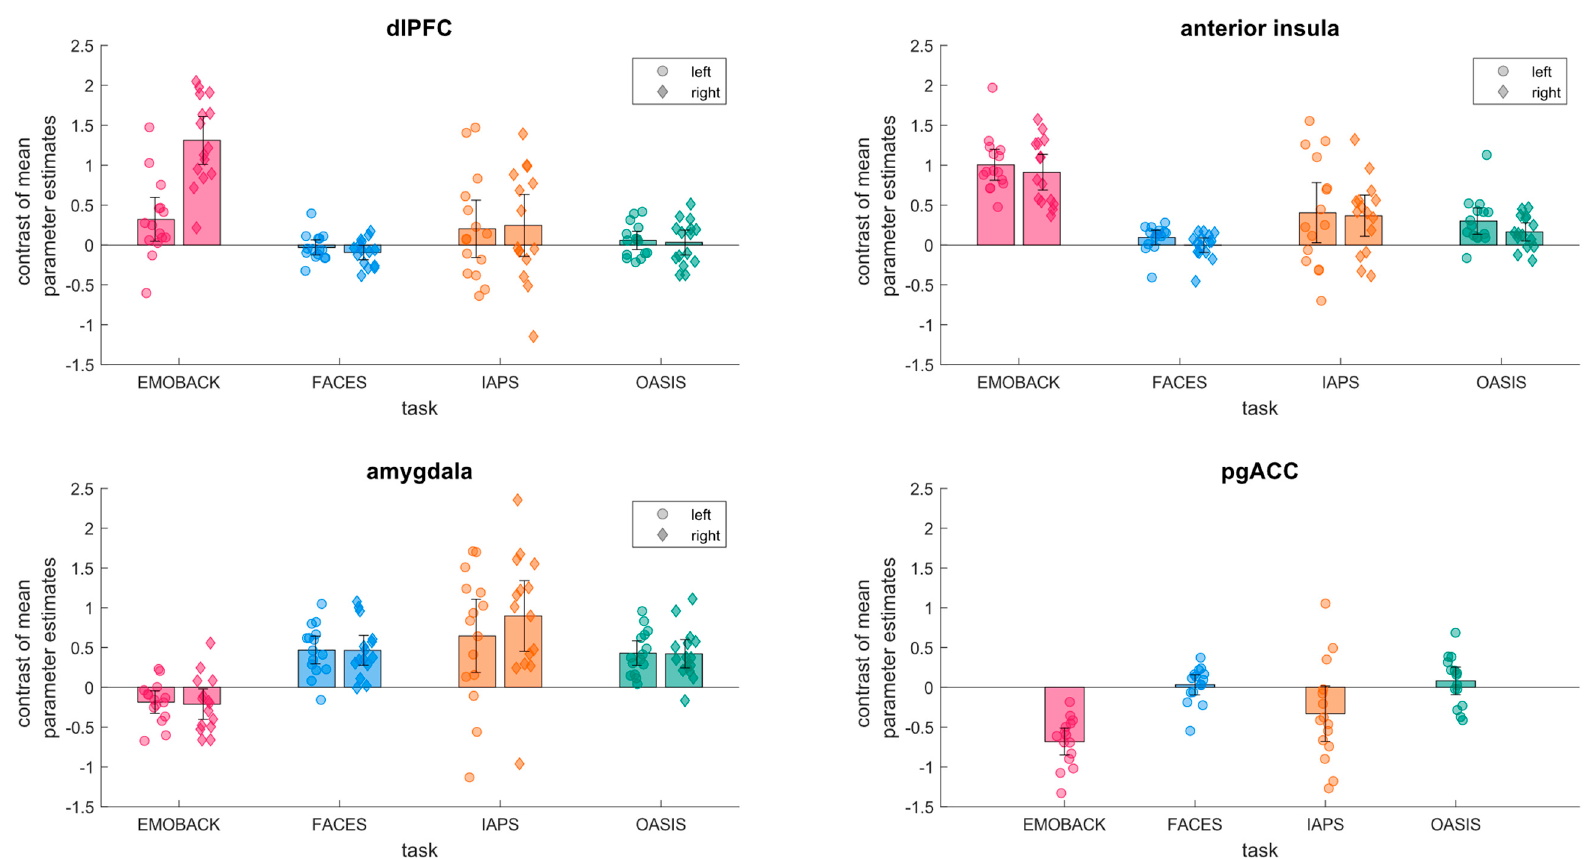
Figure 2. Mean parameter estimates of neuronal activation in the prespecified regions of interest on the group (bars) and individual (dots) level. Error bars represent the 95% confidence interval. Colors represent the four tasks; pink: EMOBACK (Emotional > break), blue: FACES (Negative > scrambled), orange: IAPS (Emotional > break), green: OASIS (Negative > scrambled).